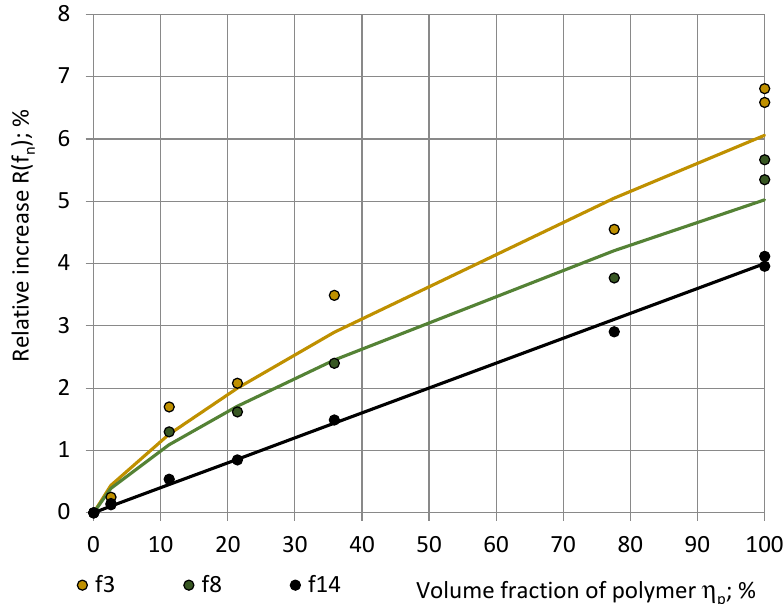
Figure 14. The relative increase R(f n ) in the true permittivity of rigid polyurethane materials in dependence of volume fraction of polyurethane at frequencies f 3 = 40 Hz (beige), f 8 = 1280 Hz (green), and f 14 = 81,920 Hz (black).